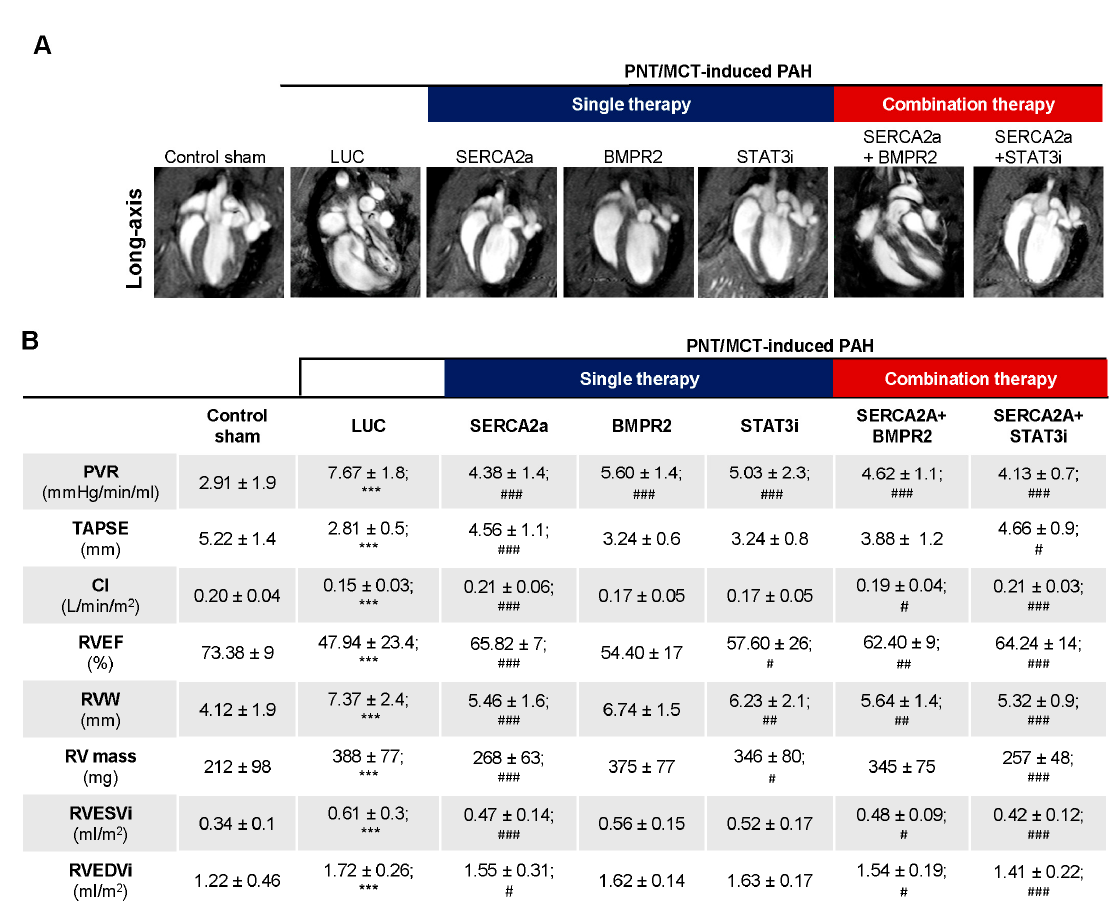
Figure 6. Cardiac magnetic resonance (cMRI) imaging of PNT/MCT-PAH rats after single and combination therapies. ( A ). Representative images of cMRI pictures in long-axis are shown in the indicated conditions. ( B ). Cardiac hemodynamics were measured by cMRI in control (Sham, n = 8) and PNT/MCT-PAH rats treated with aerosolized AAV1.LUC (n = 7), AAV1. h SERCA2a (n = 11), AAV1. h BMPR2 (n = 9), or intraperitoneally injected with a STAT3i alone (n = 6), or in combination as follows: AAV1. h SERCA2a/AAV. h BMPR2 (n = 5) or AAV1. h SERCA2a/STAT3i (n = 5). PVR: pulmonary vascular resistance; TAPSE: tricuspid annular plane systolic excursion; RVEF: right ventricular ejection fraction; RVW: right ventricle width; RV mass: right ventricle mass; RVESVi: right ventricular end-systolic volume index; RVEDVi: right ventricular end-diastolic volume index; CI: cardiac index. *** p < 0.001 vs. Sham. # p < 0.05 vs. LUC, ## p < 0.01 vs. LUC, ### p < 0.001 vs. LUC.